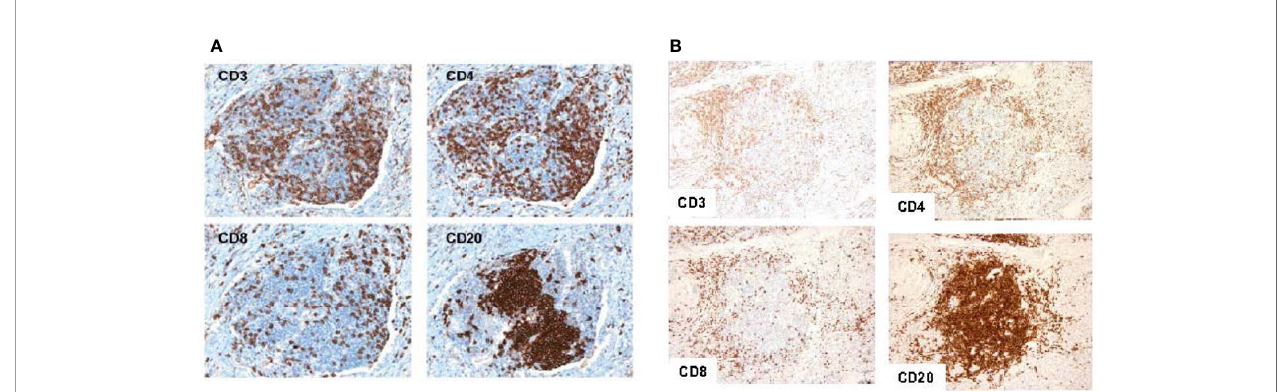
FIGURE 2 | Representative tertiary lymphoid structures found in 12-CK high samples. Typical tertiary lymphoid structure with CD20+ B cells concentrated as a follicle, and CD3+, CD4+, and CD8+ T cells appearing in the parafollicular cortex or marginal zones and with some dispersion into the follicle in a melanoma tumor sample (A) . (Adapted from Messina et al., Sci Rep , 2012; Prabhakaran et al ., Breast Cancer Res , 2017). Similar patterns of cellular distribution and structure are recapitulated in breast tumor samples (B)